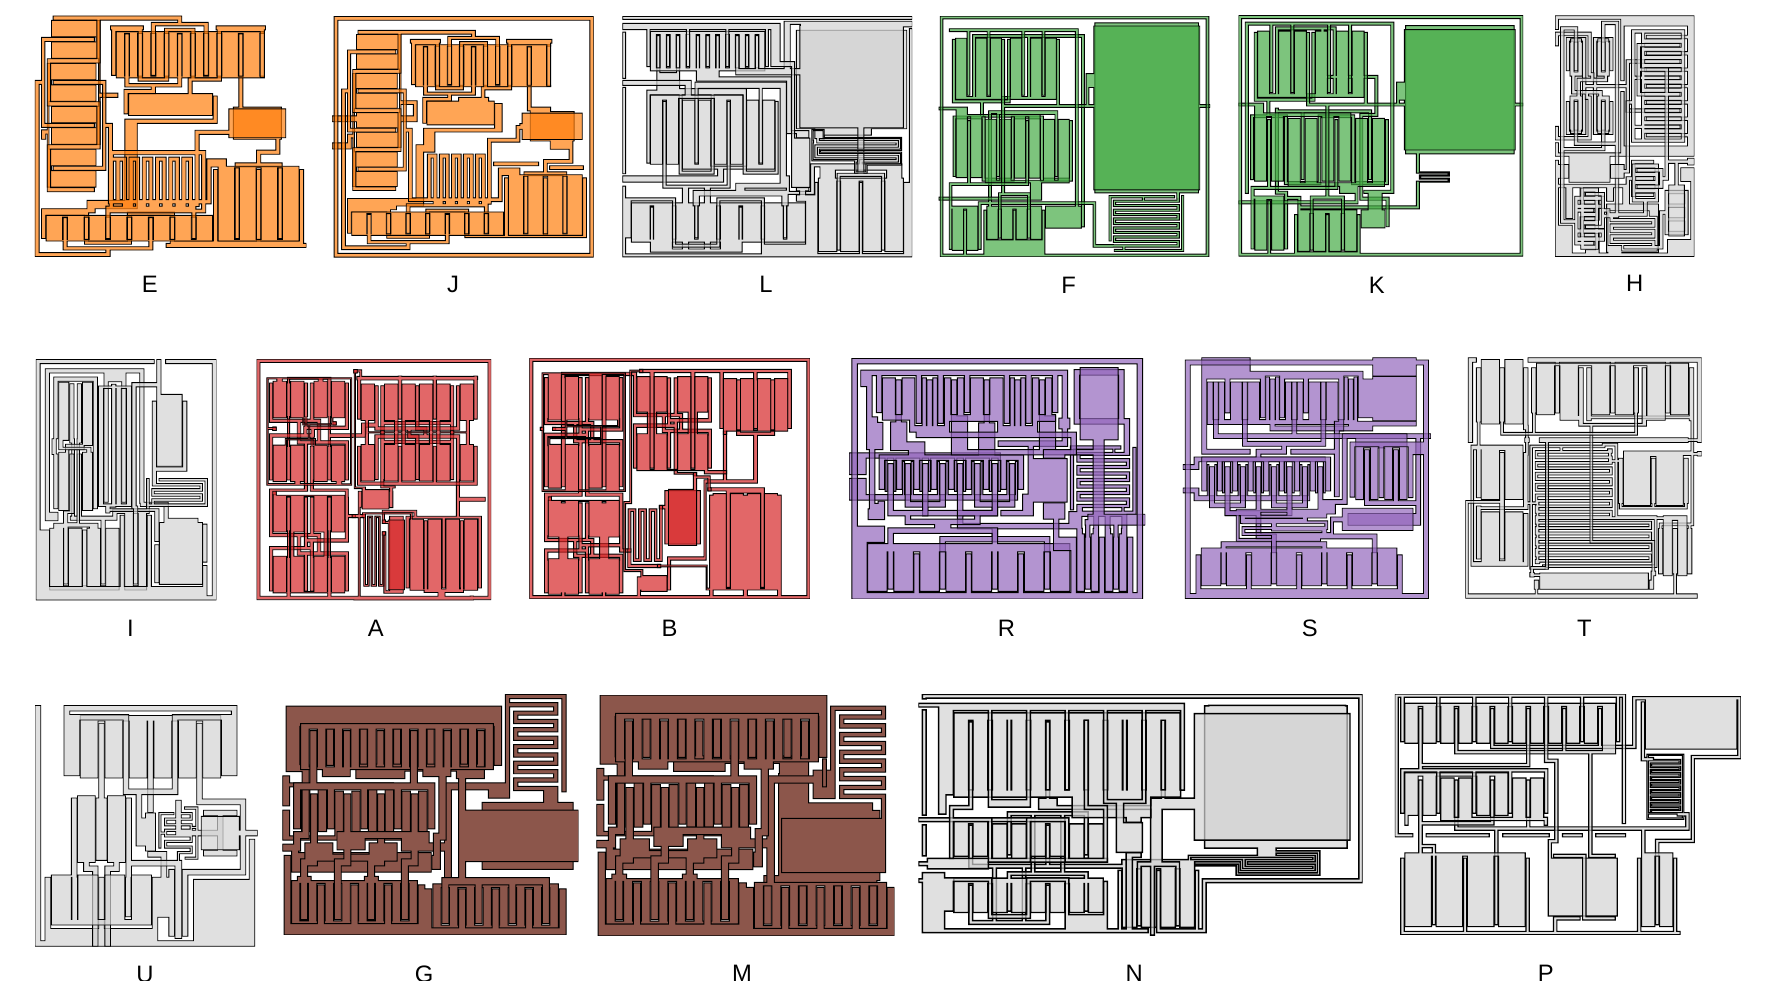
Figure A2. Nets extracted from the 17 OTAs whose mutual similarity was shown in the dendrogram in Figure